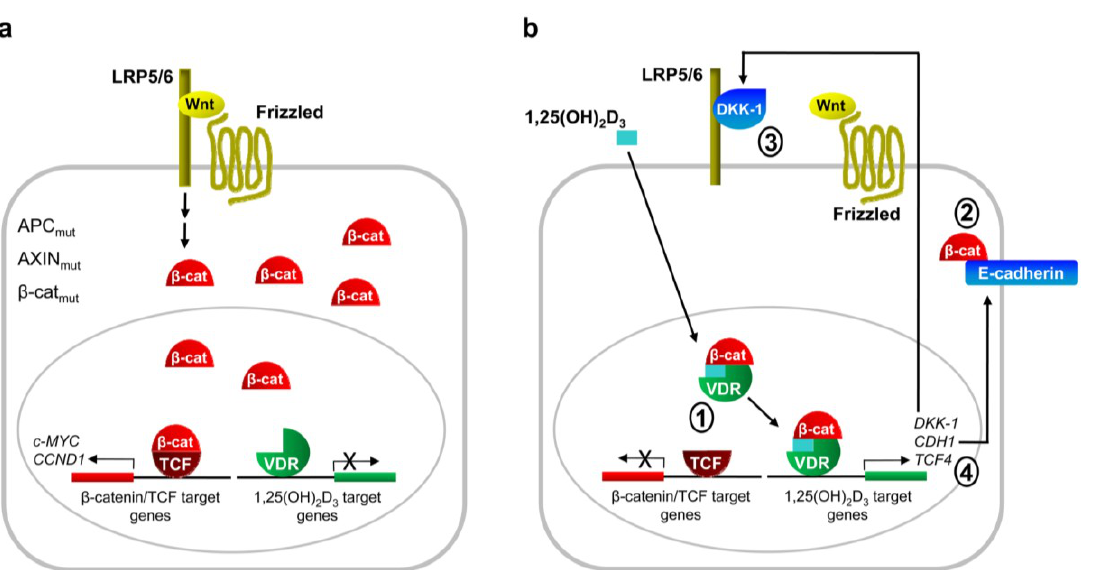
Figure 1. Schematic representation of the mechanisms of Wnt/  -catenin pathway repression by 1,25(OH) D in human colon carcinoma cells. ( a ) Wnt/  -catenin pathway is 2 3 activated by mutation of APC , CTNNB1 /  -catenin or AXIN genes, or by deregulated signaling from Wnt plasma membrane receptors. These alterations cause accumulation of  -catenin protein in the cytoplasm and nucleus and transcription of its target genes; ( b ) 1,25(OH) D inhibits  -catenin/TCF transcriptional activity in colon carcinoma cells by 2 3 several mechanisms. It promotes VDR/  -catenin binding, thus reducing the amount of  -catenin bound to TCF (1); it induces the expression of CDH1 gene coding for E-cadherin, which sequesters  -catenin at the plasma membrane adherens junctions (2); and it enhances the expression of the extracellular Wnt inhibitor DKK-1 (3) and of TCF4 (4). Additional paracrine mechanisms of antagonism have been